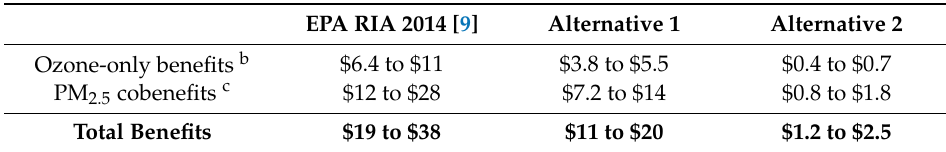
Table 3. Estimated Monetized Ozone and PM 2.5 Benefits for a 0.065 ppm standard: EPA, Alternative 1, and Alternative 2 (billions of 2011$) a